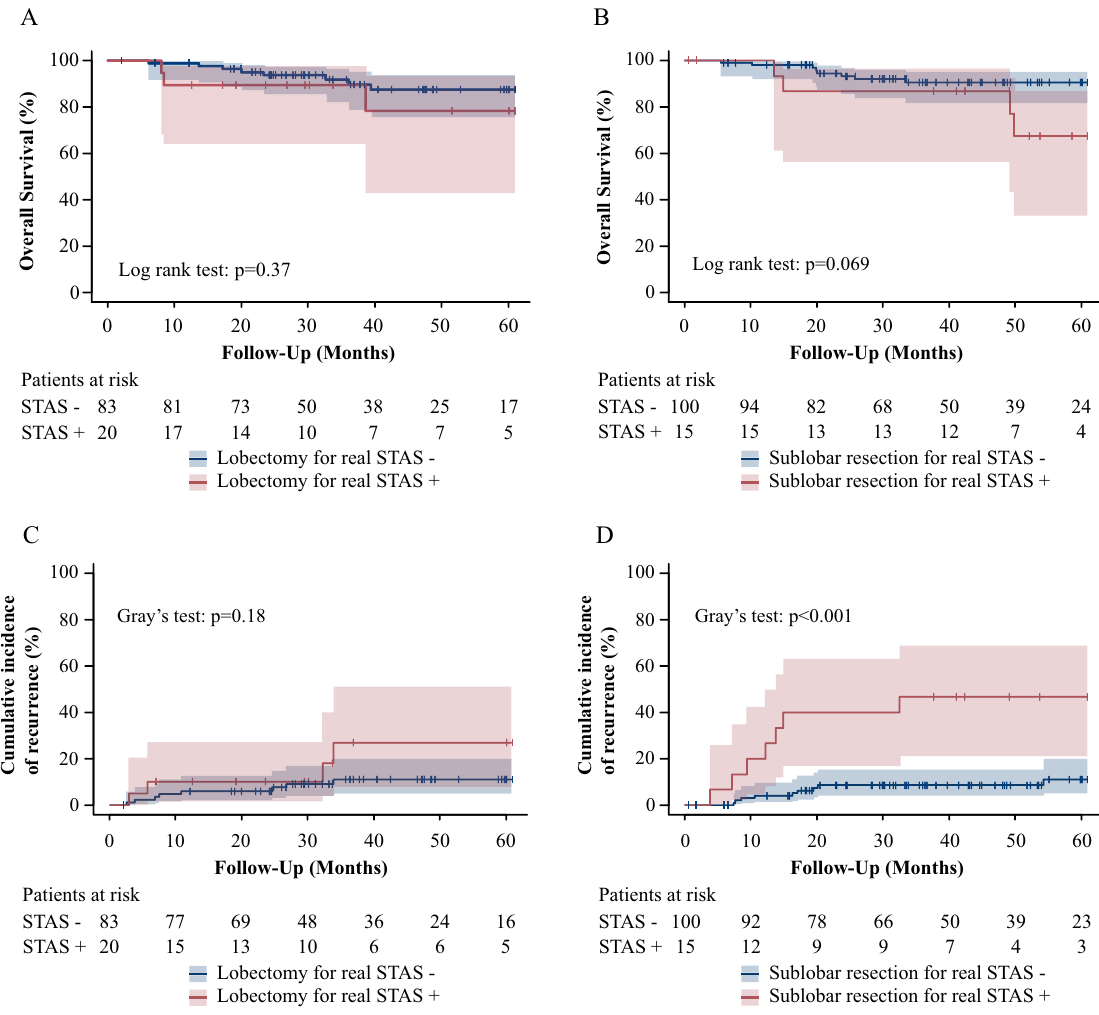
Figure 3. (R version 3.5.1, R Core Team (2018). R: A language and environment for statistical computing. R Foundation for Statistical Computing, Vienna, Austria. URL http:// www.R- proje ct. org/). The OS and CIR associated with real STAS in lobectomy and sublobar resection. Shaded areas represent 95% confidence limits. ( A ) The OS in patients who underwent lobectomy. ( B ) The OS in patients who underwent sublobar resection. ( C ) The CIR in patients who underwent lobectomy. ( D ) The CIR in patients who underwent sublobar